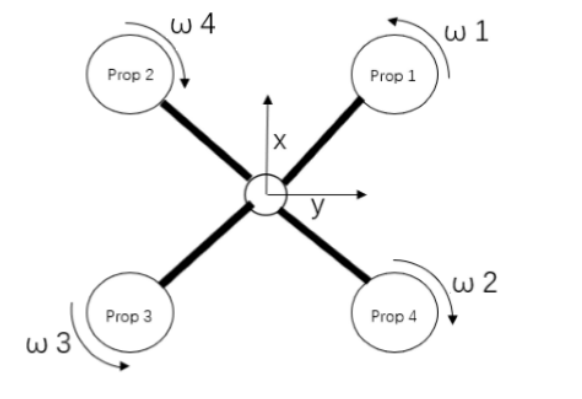
Figure 1. Quadrotor in cross (x)